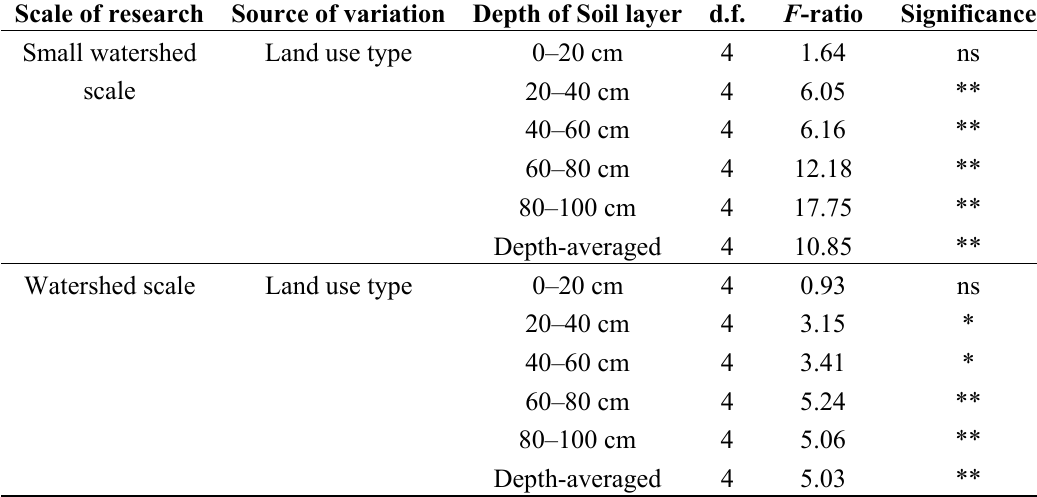
Table 3. One-way analysis of variance (ANOVA) for the effects of land use type on soil moisture